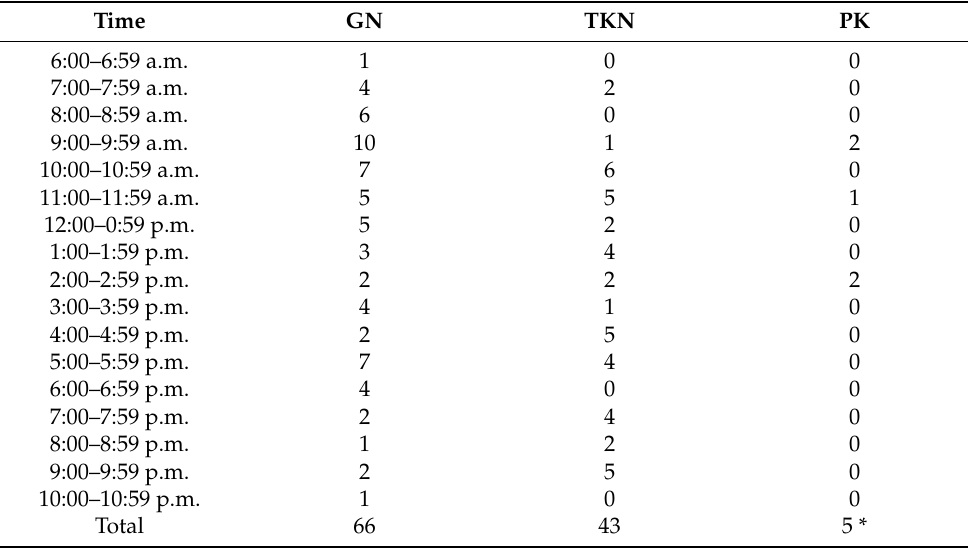
Table 5. Share of number of tweets at a given time throughout the week (N =